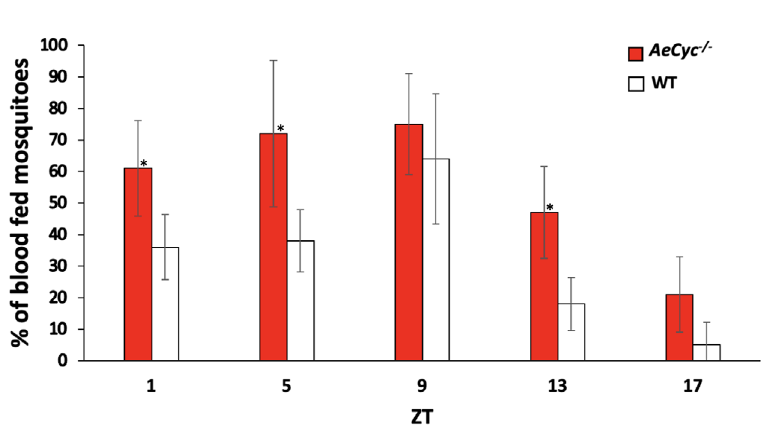
Figure 7. AeCyc −/− and wildtype Ae. aegypti blood-feeding behavior. Mosquitoes were allowed to feed for 20 min and a total percentage of blood fed mosquitoes (includes partially and fully fed) in each time point was scored and plotted. Error bars indicate the standard error. *Statistically significant p ≤